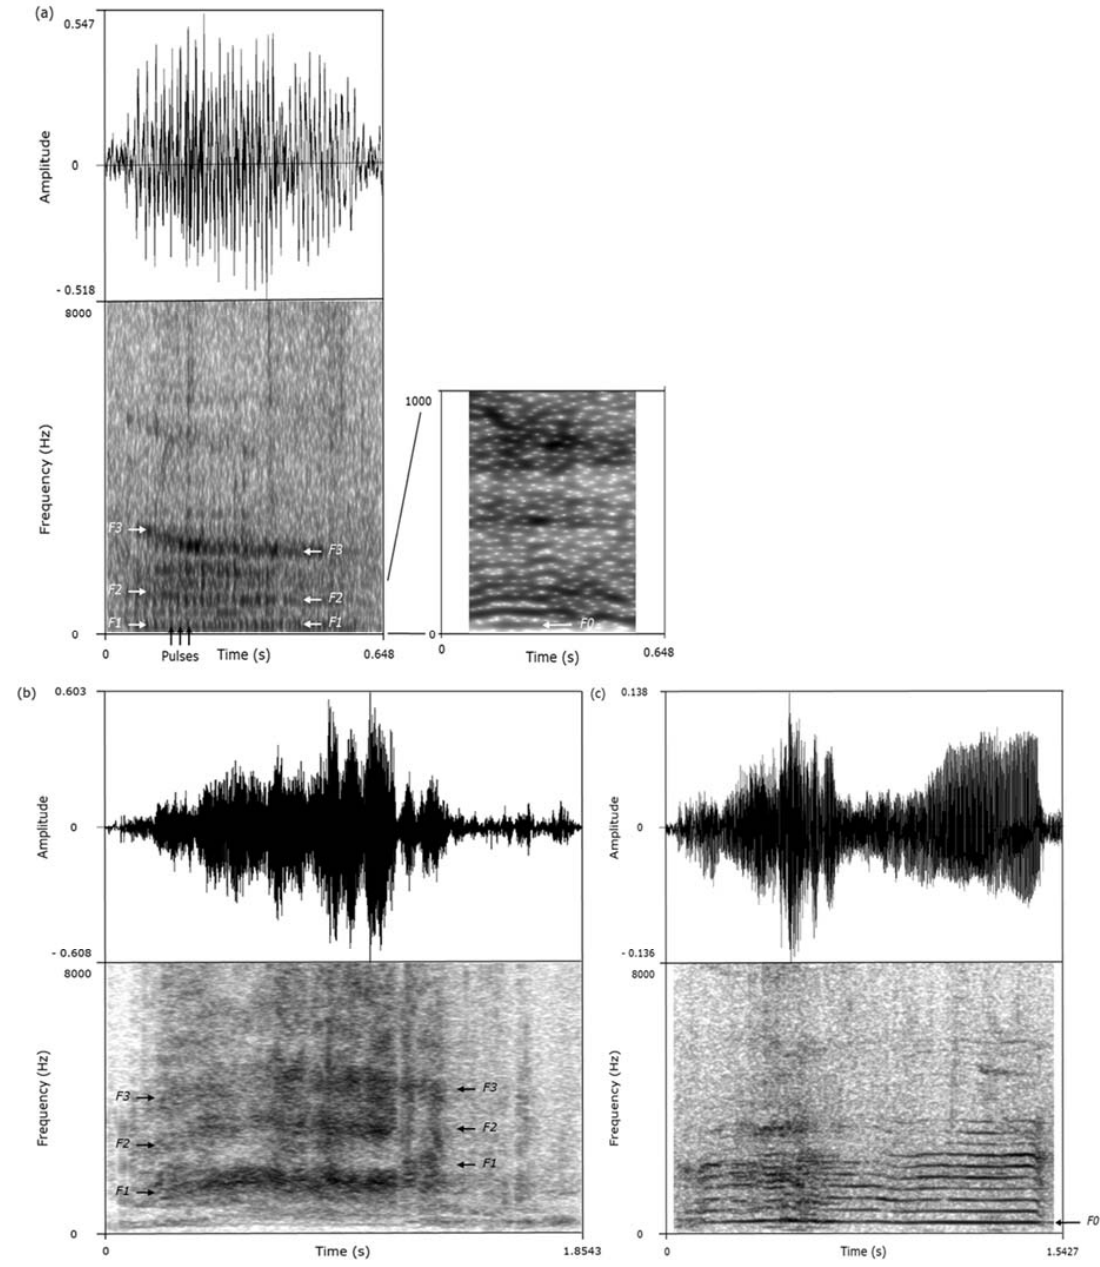
Figure 1. Oscillograms (above) and spectrograms (below) of ( a ) a grunt, ( b ) a scream, and ( c ) a squeal produced by wild boars. Fundamental frequency (F0) and F1, F2, and F3 (first three formants) are shown. These calls are available as audio files (Audio S1–S3). Table 3. Number of grunts, screams, and squeals analyzed according to the valence and the situation for each individual (including range; n = 19 animals).